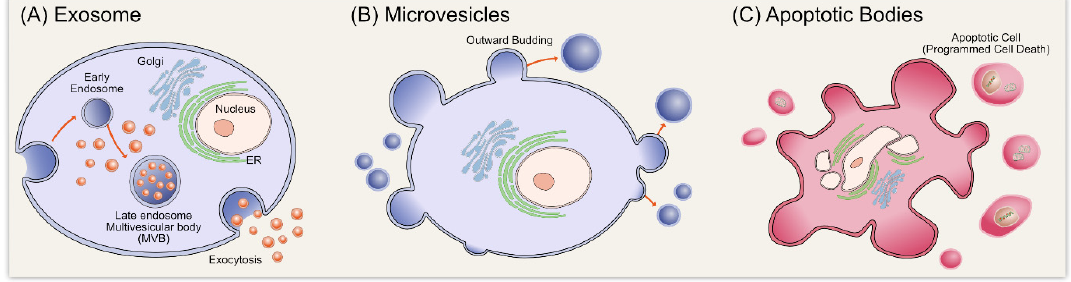
Figure 1. Schematic representation of extracellular vesicles.